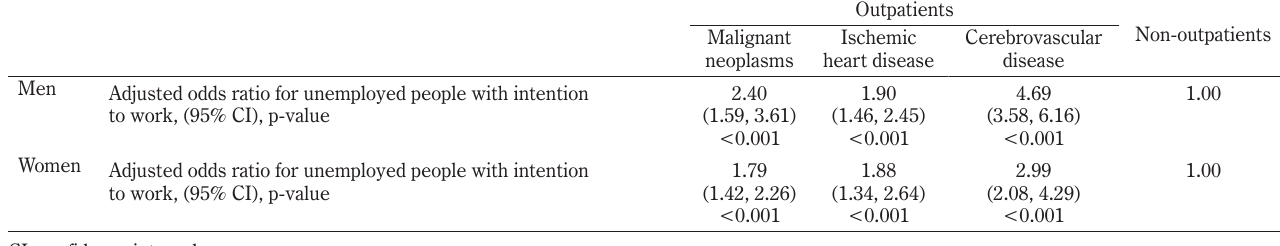
Table 3 Adjusted odds ratios for unemployed people with the intention to work among outpatients with malignant neoplasms, ischemic heart disease, and cerebrovascular disease, compared with non-outpatients